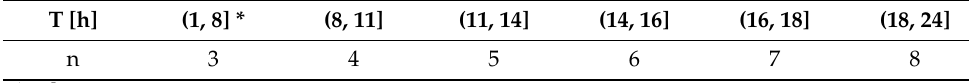
Figure 4. Chi-square distribution probability density function plot [33]. Table 2. The rainfall ephemeris corresponds to the degree of freedom